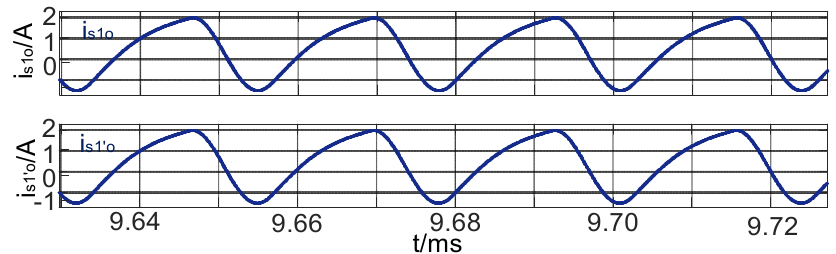
Figure 13. The input-current waveform of IDC parallel resonance on load mode .